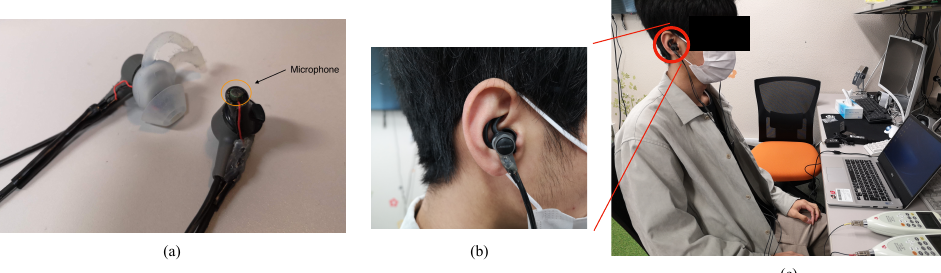
Figure 3. Photos of a special earphone and measurements. ( a ) a special earphone. ( b ) the subject wearing the earphone. ( c ) measurements. The earpieces in ( b , c ) are black, however the white earpieces shown in ( a ) were used in the